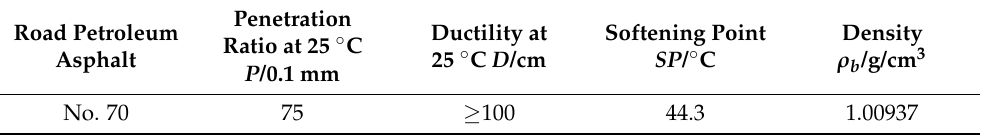
Table 1. Mainly physical performance indexes of No. 70 road petroleum